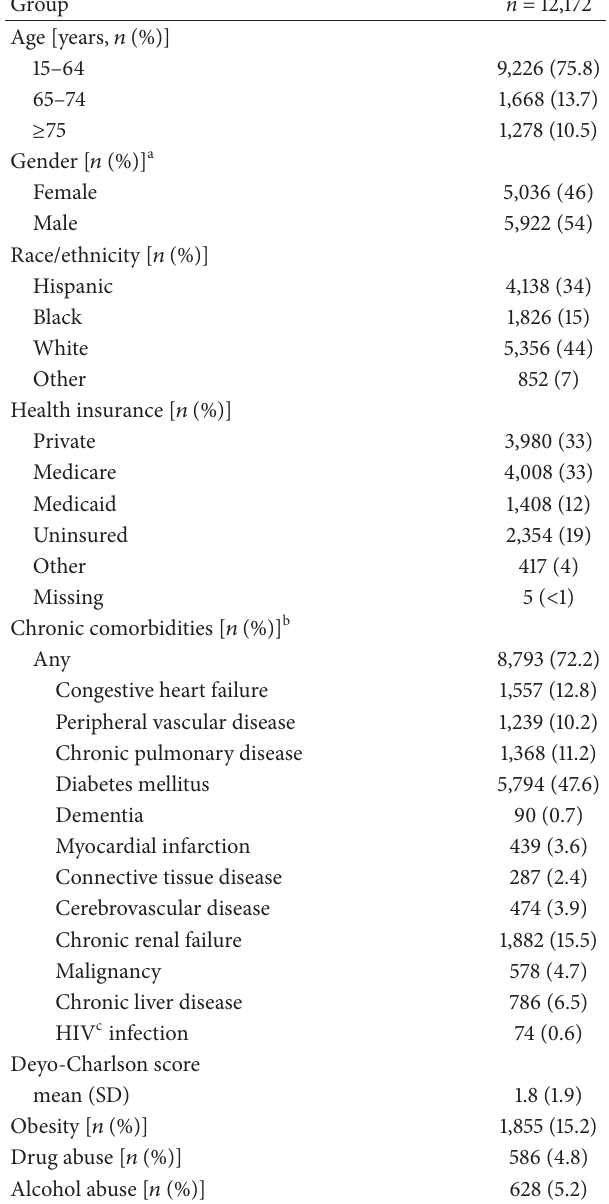
Table 1: Characteristics of NF